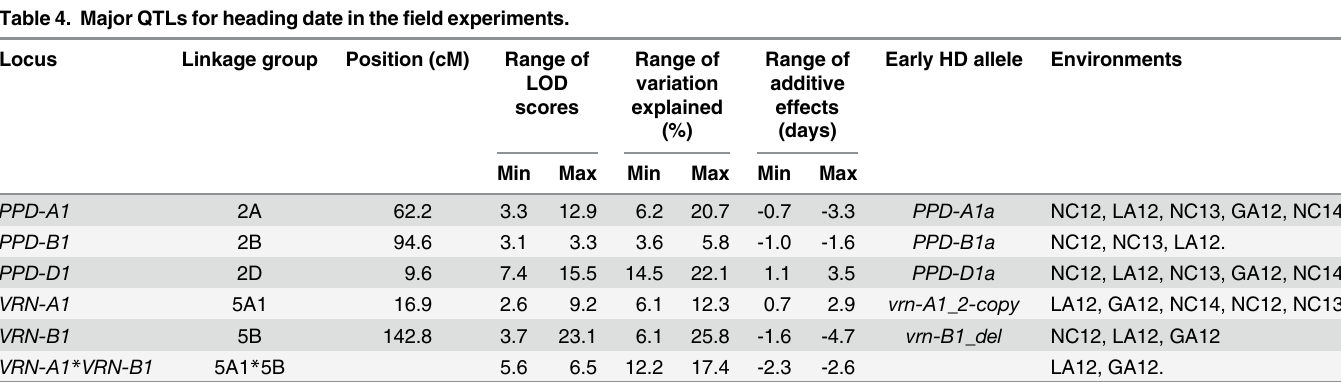
Table 4. Major QTLs for heading date in the field